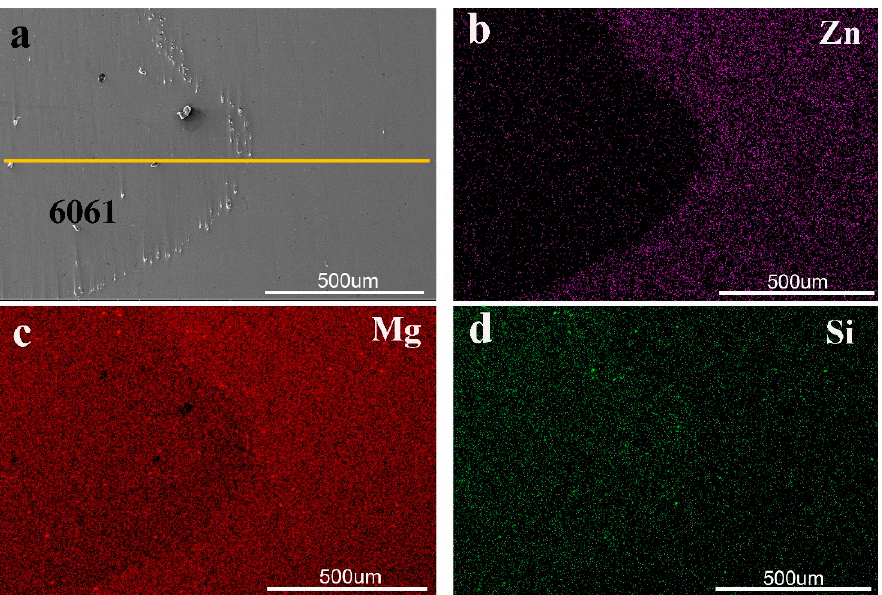
Figure 5. The second electron image of the weld joint and the corresponding EDS mappings. ( a ) The second electron (SE) image, ( b – d ) the mapping of Zn, Mg and Si.